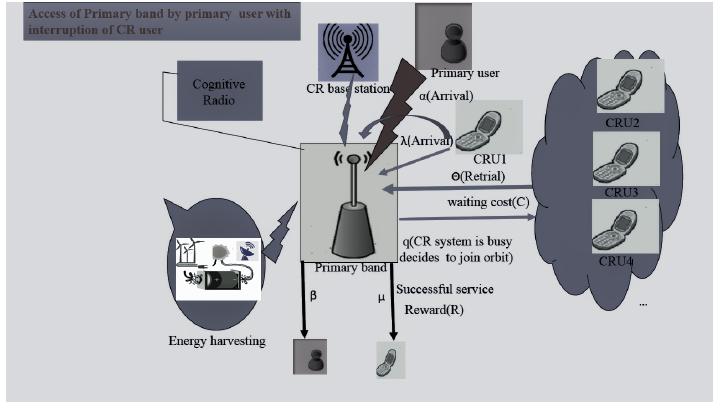
Figure 1. Model’s schematic